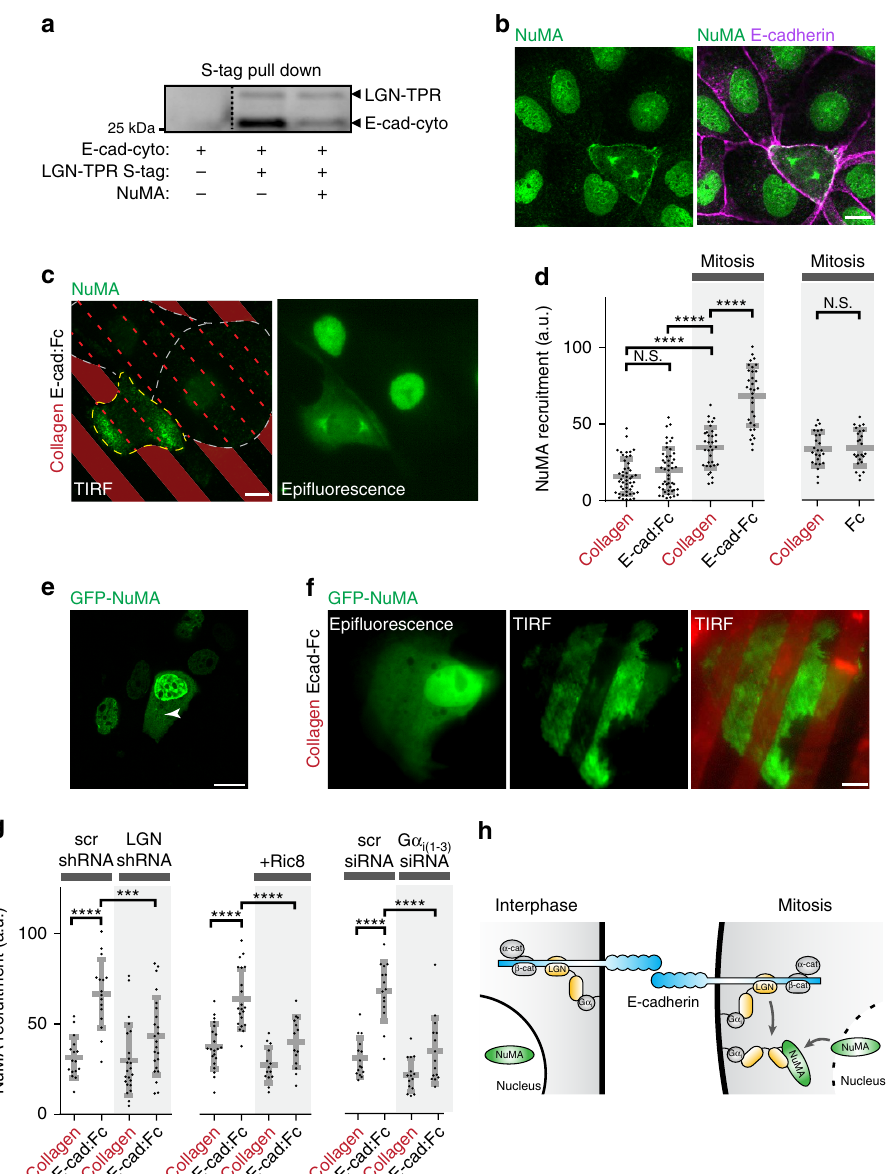
Figure 5 | E-cadherin localizes the mitotic LGN/NuMA complex to cell–cell contacts. ( a ) S-protein agarose pull down of recombinant LGN–TPR and E-cadherin cytoplasmic tail in the presence or absence of NuMA peptide, immunblotted for LGN and E-cadherin, showing the competition of E-cadherin cytosolic tail from LGN–TPR:S-tag by the LGN-binding domain of NuMA. ( b ) Localization of endogenous NuMA and E-cadherin in interphase and mitotic MDCK cells. ( c ) TIRF and epifluorescence microscopy of NuMA in MDCK cells plated on micro-patterned alternating stripes of collagen-IV/E-cad:Fc. Cells are outlined in yellow (mitotis) and grey (interphase), for increased clearness stripes are shown as projections in the TIRF image. ( d ) Quantification of NuMA fluorescence intensity at the plasma membrane bound to stripes coated with different proteins in interphase and mitotic cells. ( e ) Cytosolic localization of over-expressed GFP-NuMA in interphase MDCK cells, showing its cytosolic accumulation (marked with an asterisk) in cells with high expression. ( f ) Localization of GFP-NuMA on MDCK cells plated on collagen-IV/E-cad:Fc micro-patterned surfaces visualized by TIRF microscopy. ( g ) Quantification of NuMA fluorescence intensity at the plasma membrane bound to different stripes in mitotic cells on shRNA-mediated depletion of LGN, disruption of LGN/G a i interactions by overexpression of Ric8, or on expression of siRNAs targeting G a i 1, G a i 2 and G a i 3. Representative images and epifluorescence of NuMA localization in LGN shRNA monolayers are shown in Supplementary Fig. 4a–4c. ( h ) Model for localization of the LGN/NuMA complex to cell–cell contacts by E-cadherin. By interacting with the cytosolic tail of E-cadherin, LGN is recruited to cell–cell contacts in interphase. After nuclear breakdown during mitotic entry, NuMA is released from the nucleus and competes LGN from the E-cadherin/LGN complex. The locally formed LGN/NuMA complex remains at E-cadherin adhesions through the interaction of LGN with G a i . Scale bars, 10 m m; all quantified data were pooled from three independent experiments; grey bars in dot plots show mean ± s.d.; **** P o 0.0001; *** P ¼ 0.0002, N.S. ¼ not significant, using unpaired student t -